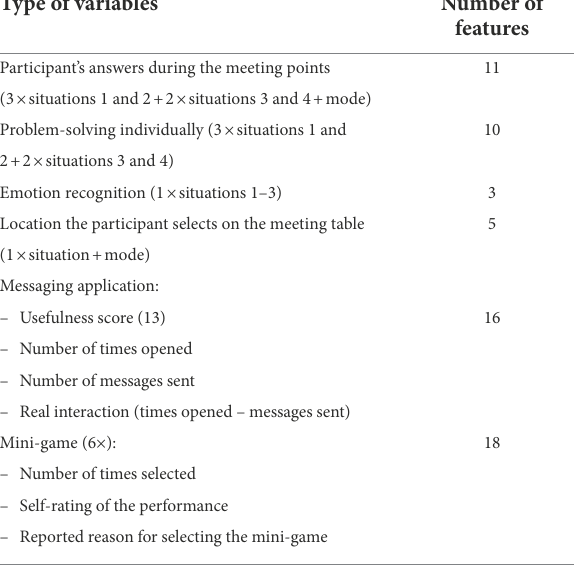
TABLE 2 Decision-making